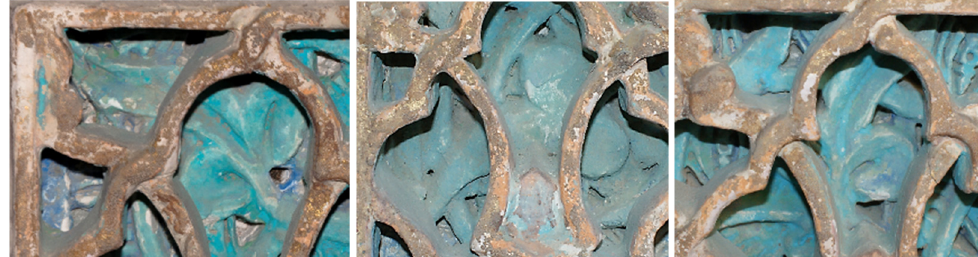
Figure 2. Images of the floral pattern on the background (authors’ own images).